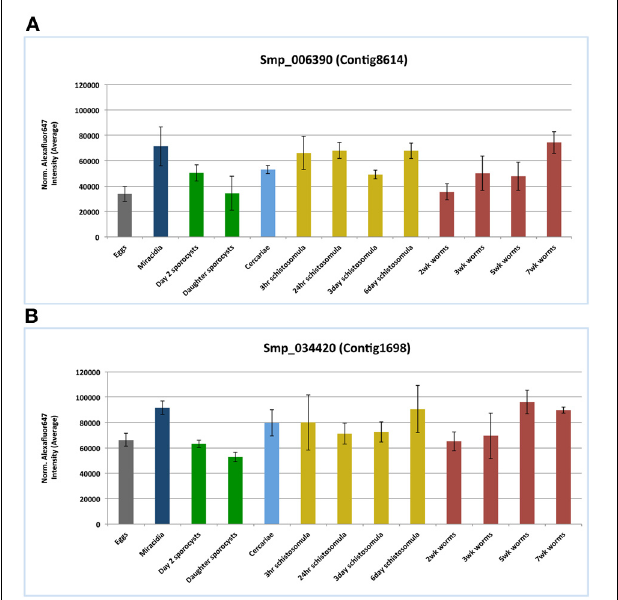
FIGURE 5 | Cystatins mRNA expression patterns in the S. mansoni life cycle. Public microarray data available at ArrayExpress (E-MEXP-2094) was downloaded to a local server in order to identify cystatins expression patterns of the I25A subfamily member Smp_006390 (A) and the I25B subfamily member Smp_034420 (B) in S. mansoni . Bars correspond to the mean normalized values for each oligonucleotide probe named Smp_006390 and Smp_034420 in 13 different life